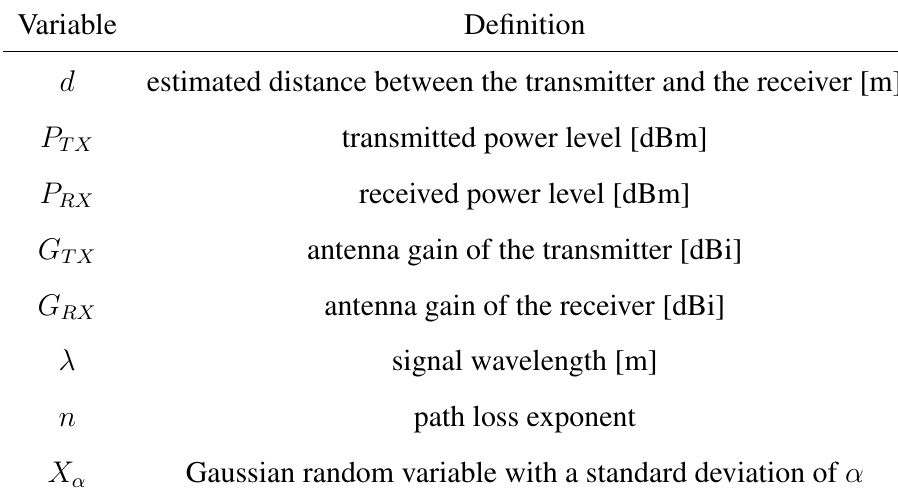
Table 1. The variables involved in Equation